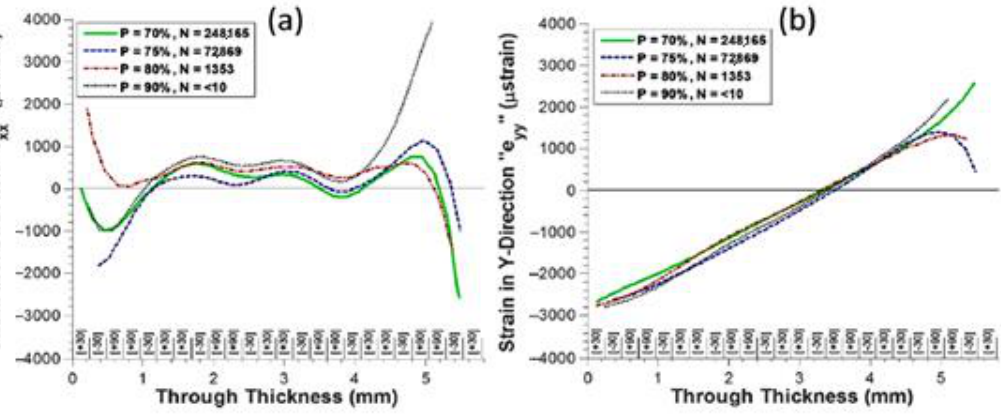
Figure 6. DIC images showing progressive damage for ( a ) P MAX = 90% and ( b ) P MAX = 70% using the correlation coefficient “sigma” [9]. Figure 7. DIC strains ( a ) ‘e xx ’ and ( b ) ‘e yy ’ for different load levels along line C – C in Figure 6 [9].